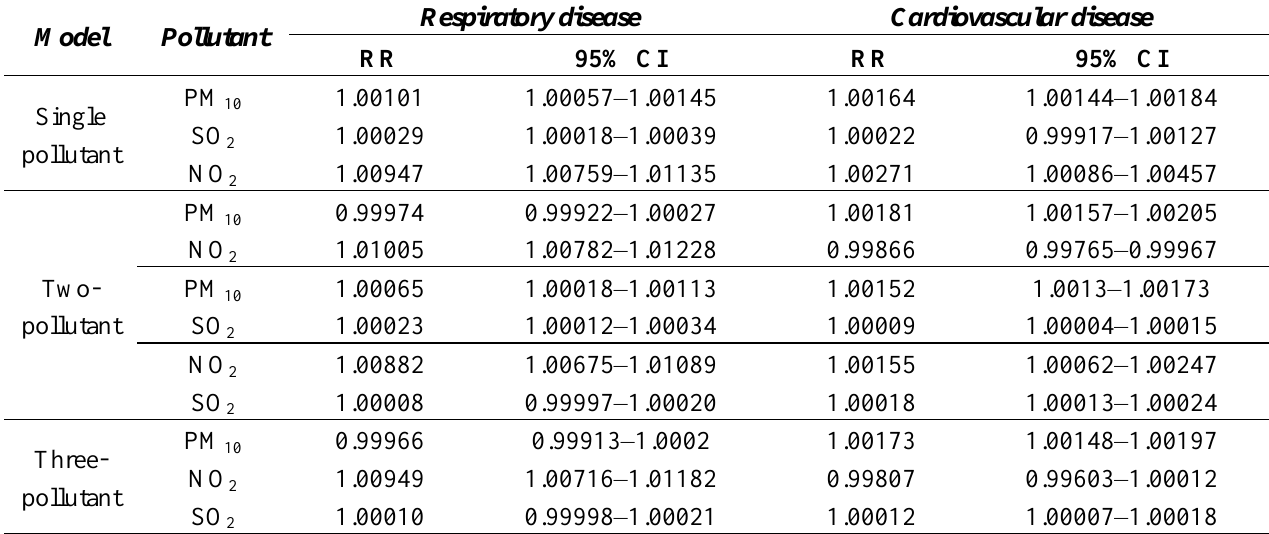
Table 5. RR for a 10 µg/m 3 increase in pollutant levels for respiratory disease mortality and cardiovascular disease